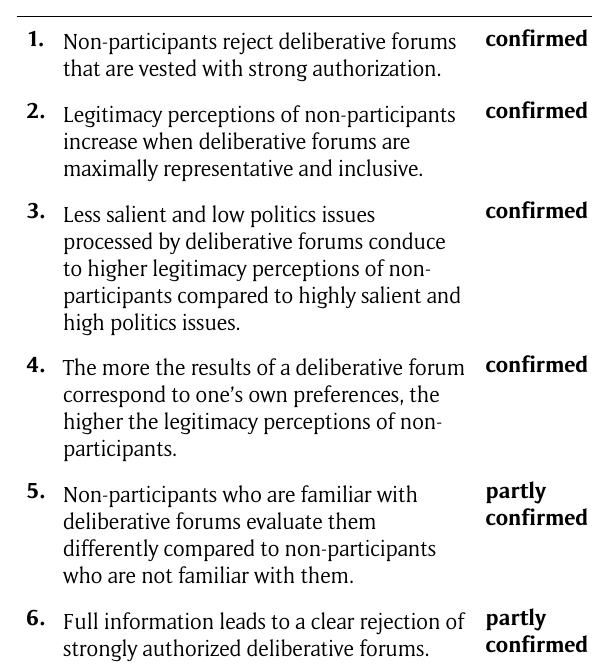
Table 4: Hypotheses